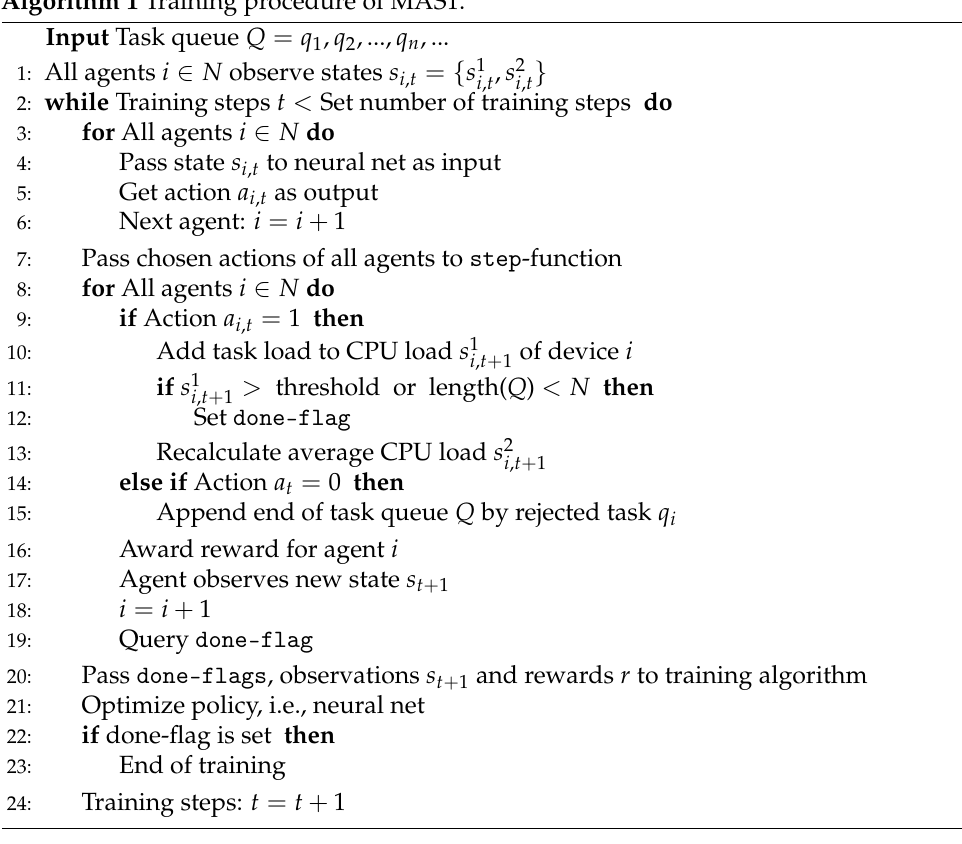
Algorithm 1 Training procedure of